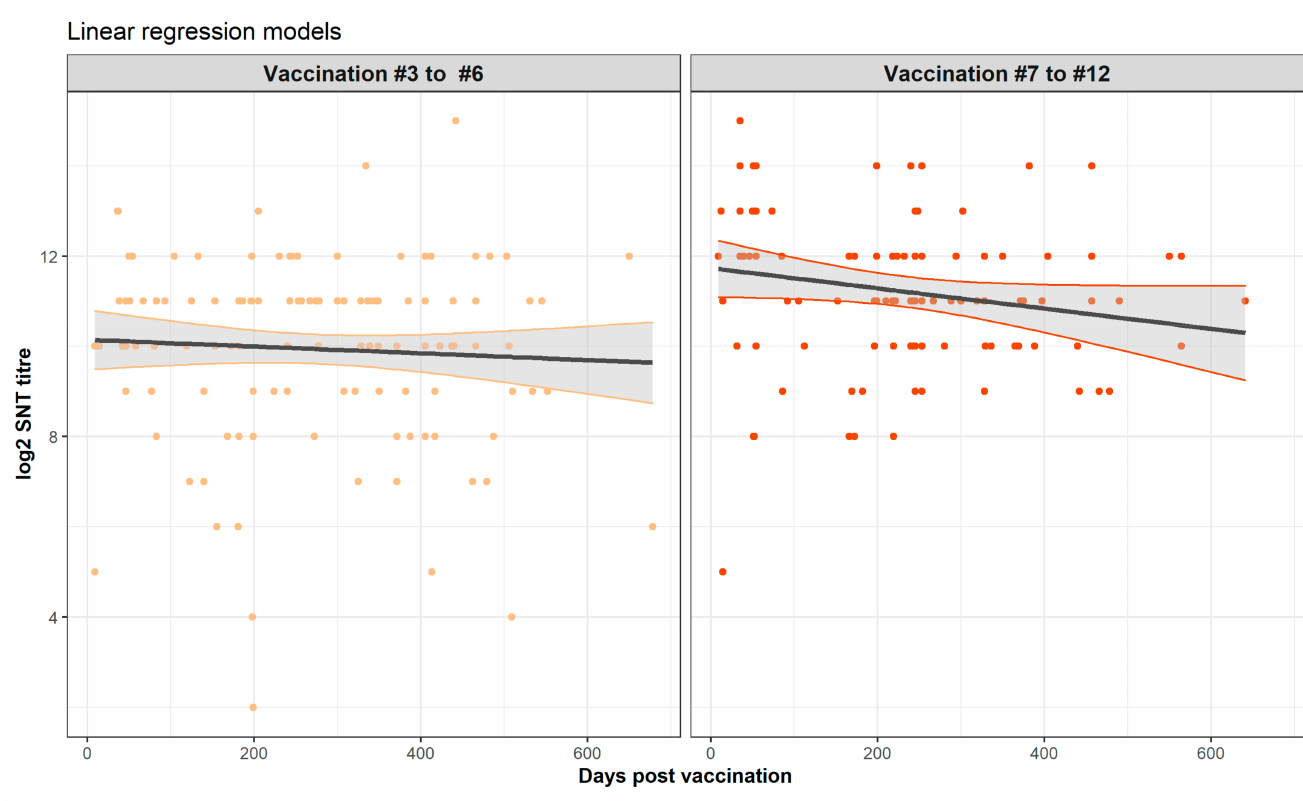
Figure 7. Final regression model showing the fitted line and 95% confidence intervals (grey shading) for vaccination 3 to 6 (left panel) and vaccination 7 to vaccination 12 (right panel) superimposed on the model predicted SNT titres. Note that whilst the intercepts for the two vaccination groupings were highly significantly different ( p < 0.001), the slopes were not significantly different ( p >